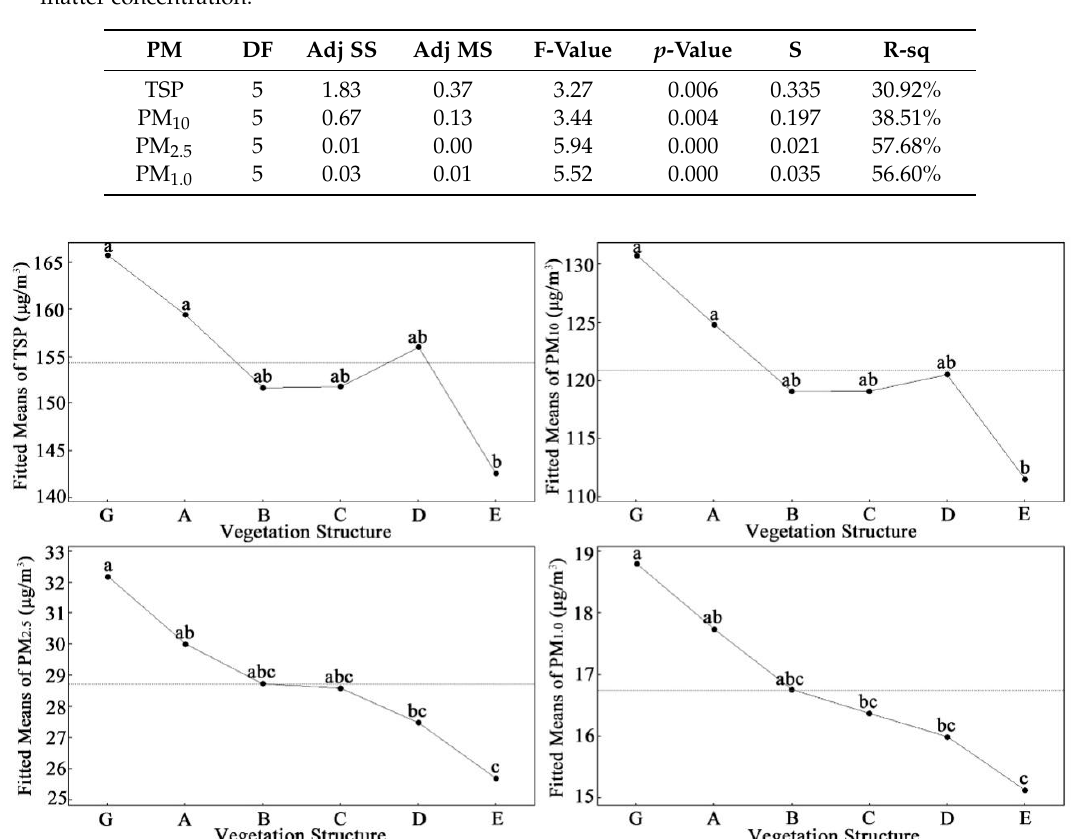
Table 4. General linear analysis of vegetation structure and atmospheric suspended particulate matter concentration.